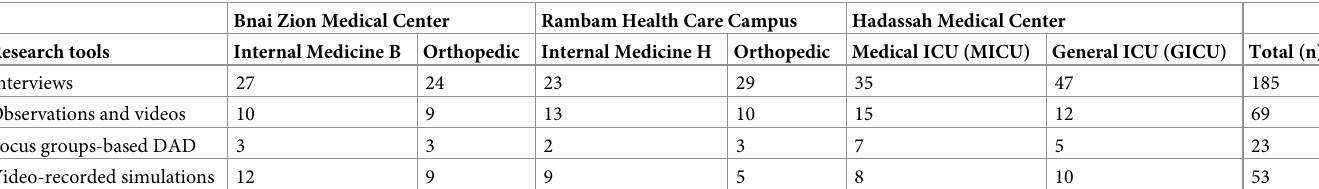
Table 1. Research tools used in the empirical study, classified according to hospital intervention